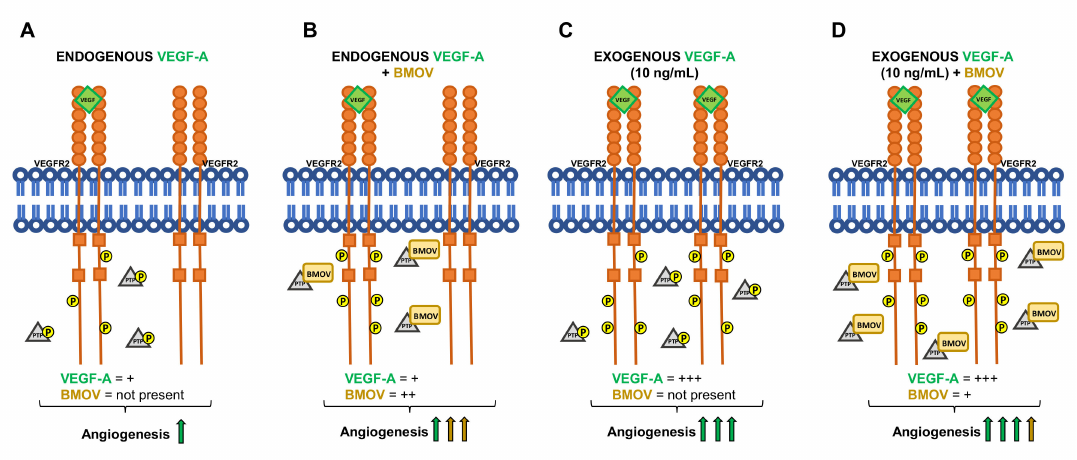
Figure 9. Schematic representation of the results obtained. ( A ) VEGF-A endogenously produced by HUVECs activates VEGFR2 resulting in its partial phosphorylation and low levels of angiogenesis. No addition of BMOV is carried out in this condition. ( B ) VEGFR2 is activated by endogenous VEGF-A and BMOV, by blocking PTPs, induces an increase in VEGFR2 phosphorylation that results in increased angiogenesis. ( C ) Exogenous addition of VEGF-A (10 ng / mL) results in increased angiogenesis via increased VEGFR2 phosphorylation. No addition of BMOV is carried out in this condition. ( D ) Coadministration of exogenous VEGF-A (10 ng / mL) and BMOV results in increased angiogenesis. The e ff ect of BMOV is indicated with yellow arrow, the e ff ect of VEGF-A is indicated with green